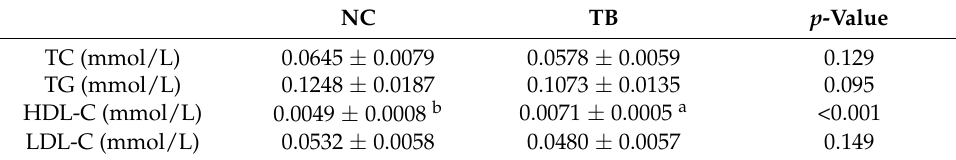
Table 3. Effect of TB on liver lipid parameters in broiler